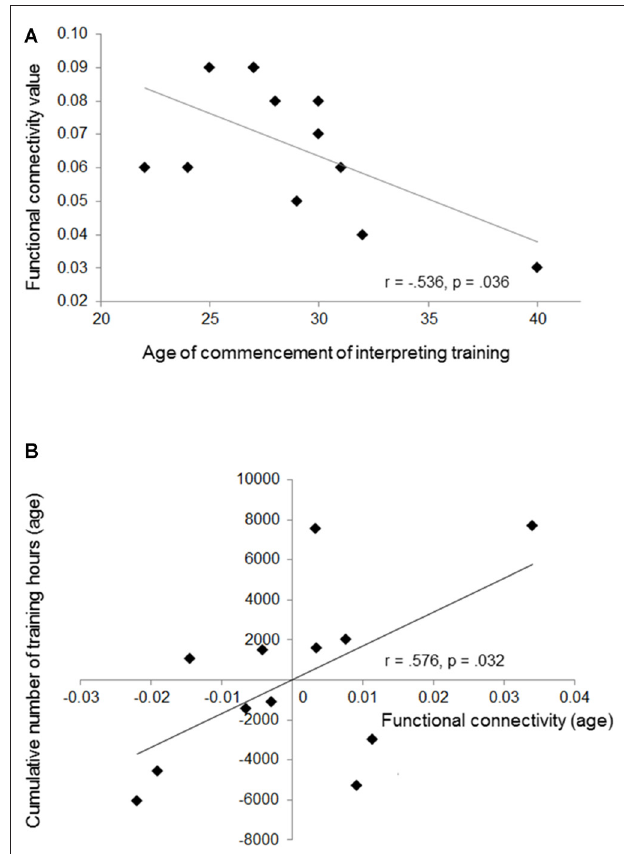
FIGURE 4 | This figure shows the negative correlation between mean functional connectivity and age of training commencement (A), and the positive relationship between cumulative number of training hours and mean connectivity (partial correlation) (B). The partial correlation is depicted by plotting residual values of training (age) against connectivity